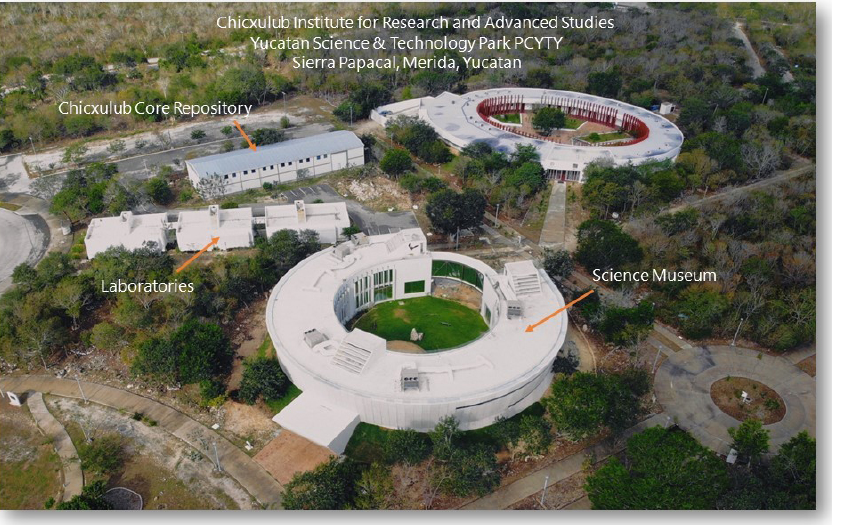
Figure 1. Chicxulub Center for Scientific Research and Advanced Studies in the Yucatán Science City of the Parque Cientifico y Tecnologico de Yucatán. Views of the Chicxulub research complex, with the museum, laboratories and core repository (photos: J. Martinez, Z. Mendoza).